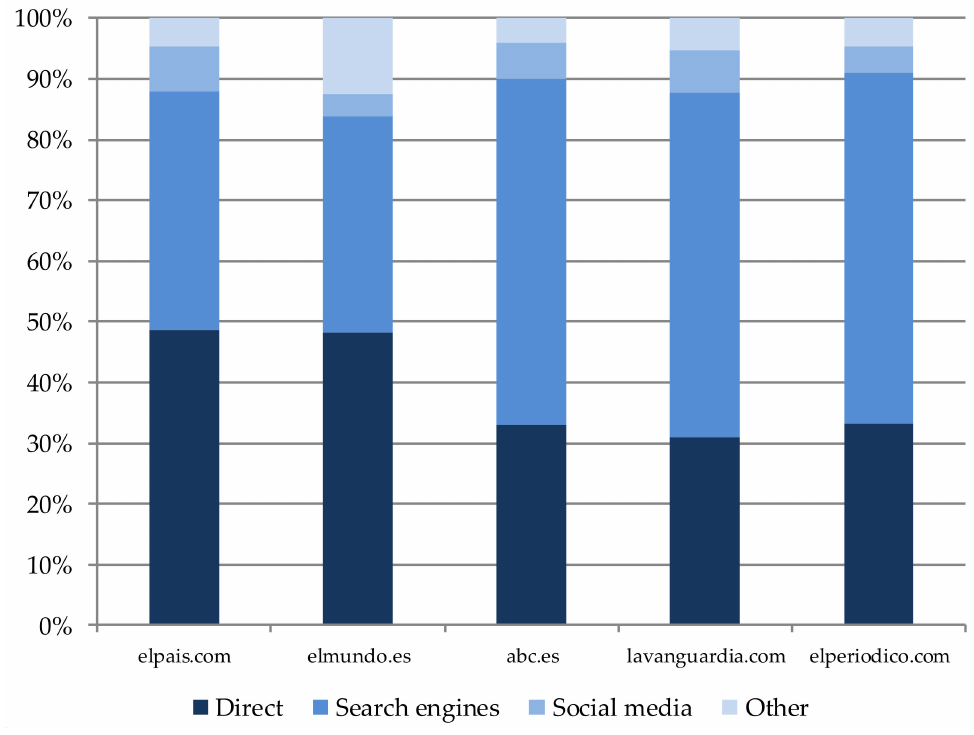
Figure 11. Online media access channels. Compiled by the authors on the basis Similarweb [42]